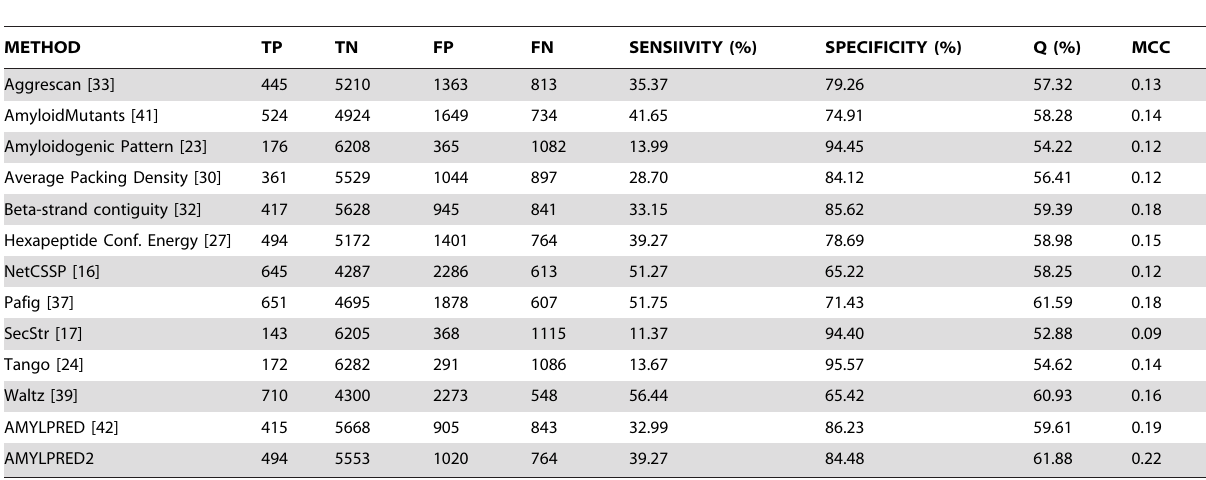
Table 1. Performance of the tool AMYLPRED2 and of its subordinate methods, on a set of 33 amyloidogenic proteins (see Table